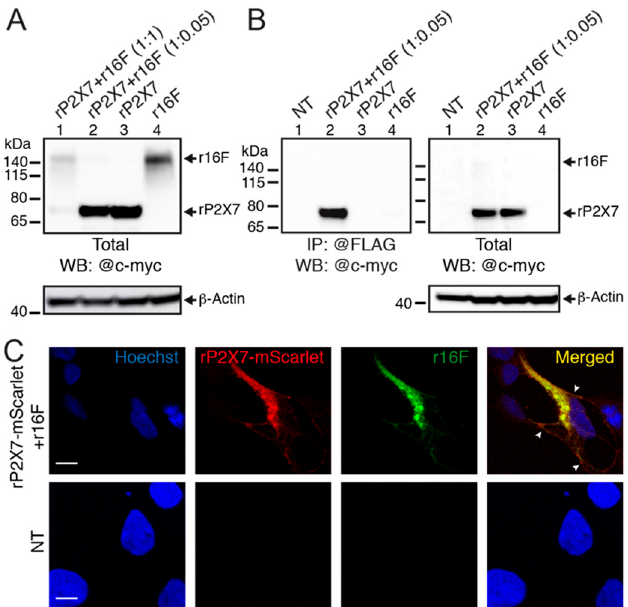
Figure 6. Physical proximity of P2X7 and TMEM16F. ( A ) Western blot of total cell lysate separated by SDS-PAGE from 16F-null cells transiently transfected with myc tagged rP2X7 (rP2X7) and myc- DDK tagged rTMEM16F (r16F) at a ratio of 1:1 (lane 1: 5 μ g rP2X7 and 5 μ g r16F) or 1:0.05 (lane 2: 5 μ g rP2X7 and 0.25 μ g r16F) and probed with anti-c-myc antibody. Note reduced rP2X7 subunit expression in lane 1 compared to that in lane 2. Control expressions of rP2X7 (10 μ g) and r16F (10 μ g) are shown in lane 3 and 4, respectively. β -Actin was used as a loading control. Apparent molecular weight markers are indicated. ( B ) Left: Co-immunoprecipitation reveals physical association of myc tagged rP2X7 and myc-DDK tagged r16F subunits transiently co-expressed at a ratio of 1:0.05 (5 μ g rP2X7 and 0.25 μ g r16F) in 16F-null cells and resolved by SDS-PAGE. Co- immunoprecipitation was performed in cell lysate with anti-FLAG antibody, which recognizes DDK tag of myc-DDK tagged r16F, and Western blotting was performed with anti-c-myc antibody. Right: Western blot of total cell lysate of corresponding samples probed with anti-c-myc antibody. Control expressions of rP2X7 (5 μ g) and r16F (0.25 μ g) are shown in lanes 3 and 4, respectively. Note that the band corresponding to myc-DDK tagged r16F is barely visualized because of the 20-fold lower expression of myc-DDK tagged r16F compared to that of rP2X7 (see, however, Figure S5D for the actual presence of r16F). Controls in non-transfected (NT) cells are shown in lanes 1. β -Actin is used as the loading control. Uncropped blots are shown in Figure S5C and D. ( C ) Top: Confocal images of 16F-null cells transiently transfected with 2 μ g rP2X7-mScarlet (red) and 0.1 μ g r16F (green) demonstrate co-localization (yellow) of both proteins. Head arrows indicate putative cell membrane localizations. Cells were stained with a primary anti-h16F antibody coupled to a secondary Alexa 488 conjugated antibody (green). Nuclei were stained with Hoechst (blue). Bottom: Control in non- transfected (NT) 16F-null cells. Scale bar, 10 μ m. Next, we asked whether the two proteins co-localize in 16F-null cells by confocal microscopy. We designed a fluorescent rP2X7 that was tagged at its C-terminus with mScarlet, a bright monomeric red fluorescent protein, and transiently co-expressed rP2X7- mScarlet with rTMEM16F at a ratio of 1:0.05 in 16F-nulls cells. By subsequently staining rTMEM16F with a primary anti-h16F antibody coupled to a secondary Alexa 488 conjugated antibody, we showed that both proteins fully co-localized in 16F-null cells (Pearson’s coefficient = 0.897 ± 0.014; n = 8 cells from 5 transfections; Figure 6C). Although most of the co-localization appears to be intracellular, putative plasma membrane co- localization was also detected (Figure 6C). 2.9. TMEM16F Shapes P2X7 Unitary Conductance